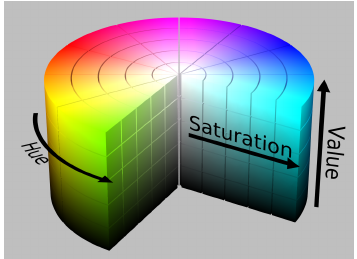
Figure 8. HSV representation of color space. From Wikipedia: SharkD / CC-BY-SA-3.0